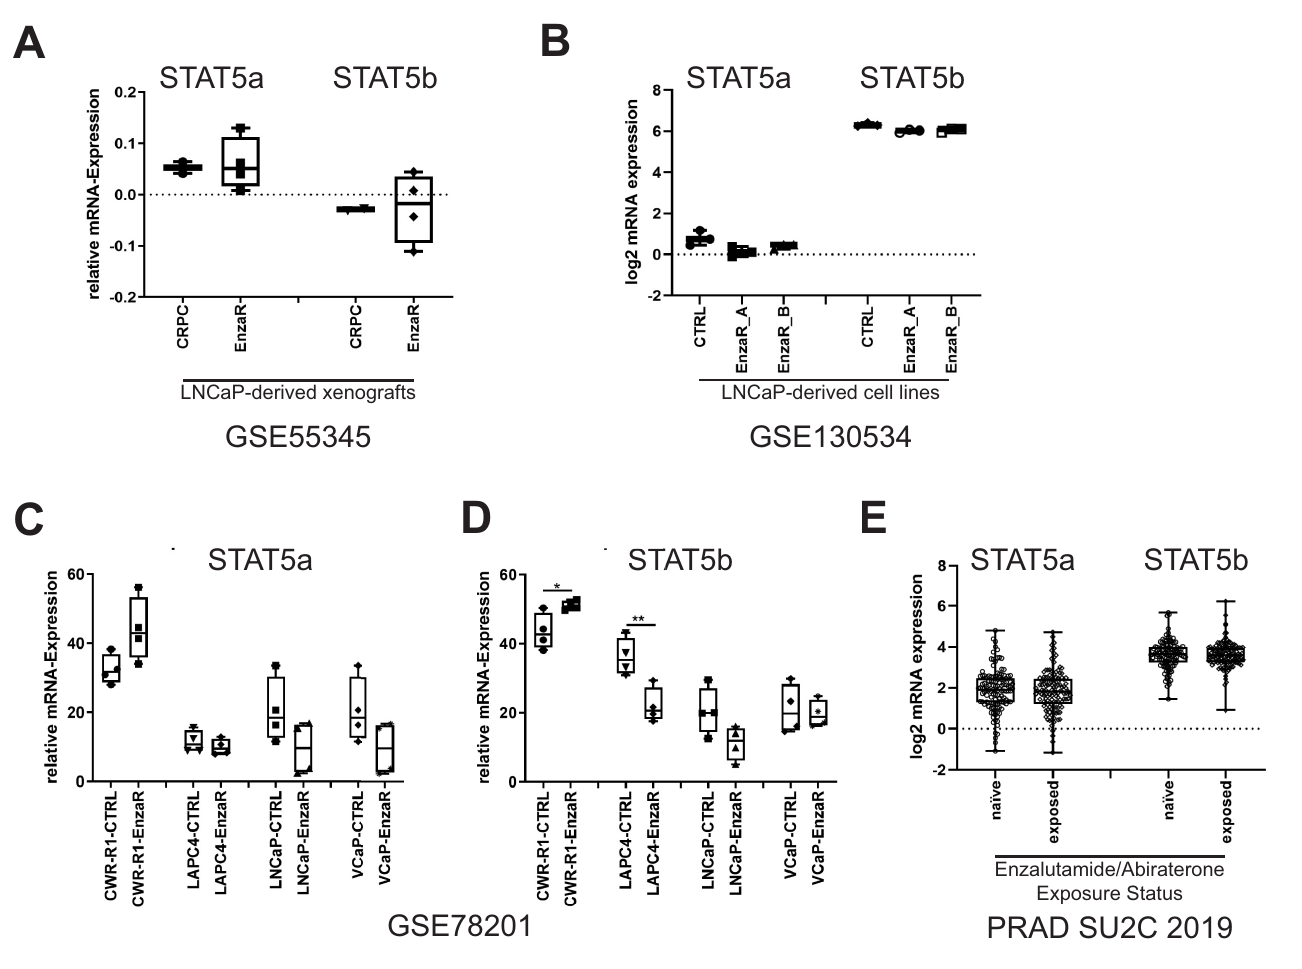
Fig 1. STAT5 expression is heterogeneous in enzalutamide-resistant cell models. Analysis of STAT5a and STAT5b mRNA expression in several datasets of (A) LNCaP-derived xenografts (GSE55345), (B) LNCaP-derived cell lines (GSE130534), (C+D) enzalutamide-resistant AR-positive PCa cell lines (GSE78201), and (E) abiraterone/enzalutamide therapy na ï ve (n = 121) and exposed (n = 128) mCRPC patients (PRAD SU2C 2019).